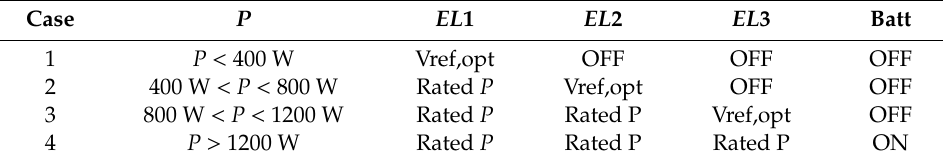
Figure 11. Principle of the control strategy of the SIBC based on the available power. HP, high-pass; PMSG, permanent magnet synchronous generator. Table 5. Power-sharing strategy according to the available power from the wind turbine.